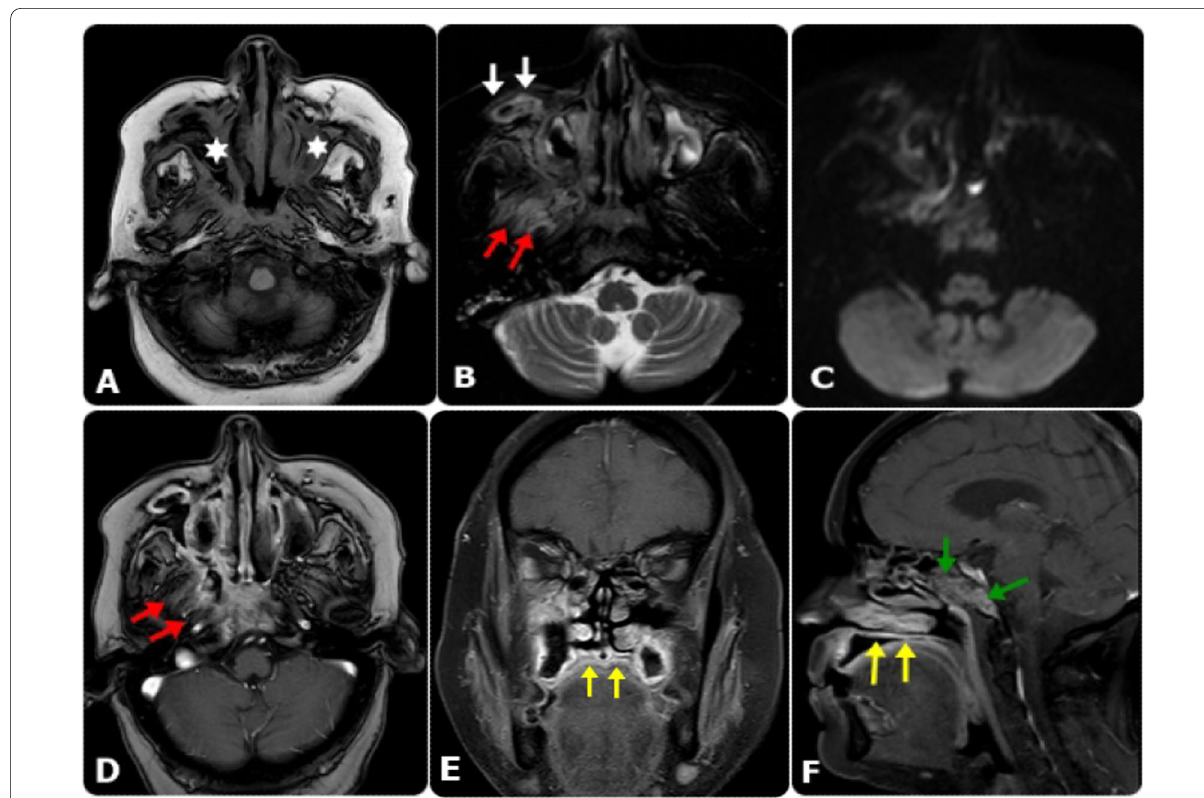
Fig. 3 MRI findings in diabetic female patient, 56 years old, presented mainly with Rt. Maxillary swelling, following COVID‑19. A Axial T1W, B and Axial T2‑SPIR images showed bilateral maxillary sinusitis (Asterisks), with mixed signal intensity within representing heterogeneous pattern of affection, associated with detected Rt. Pre‑maxillary small collection (white arrows), presented restricted diffusion on DWI at b‑value 1000 ( C ) and showing peripheral pattern of enhancement on post‑contrast axial T1W image ( D ). The edema and inflammatory process seen extending to the Rt. retro‑maxillary region (Red arrows). Coronal ( E ) and sagittal ( F ) post‑contrast fat‑saturated T1W images revealed extension of the edema and inflammatory process to the hard palate (yellow arrows) and to the base of the skull (Green